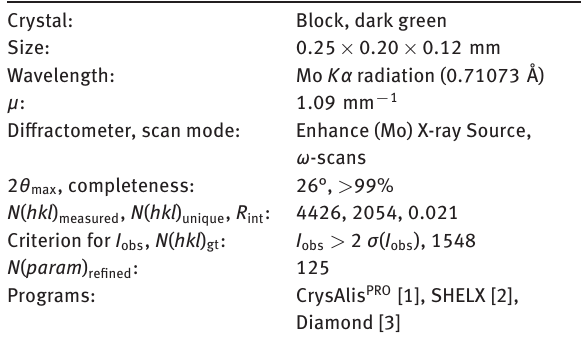
Table 1: Data collection and handling.